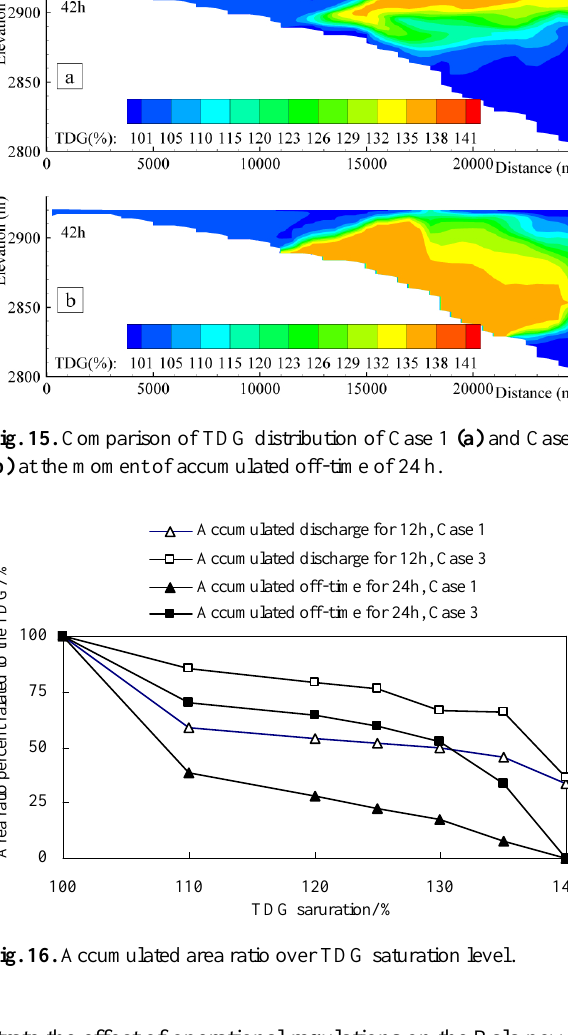
corresponding saturation for the whole reservoir. At the mo- ment when the flood discharge time accumulates to 12 h, the area ratio percent of Case 2 is much lower than Case 1. When the off-time accumulates to 24 h, the area ratio percent of the two cases is proximal, with the exception of TDG, which ranges from 130 to 135 %.